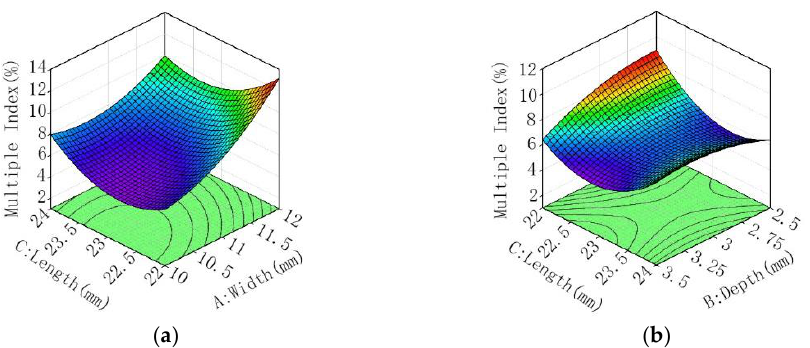
Figure 15. The impacts of interaction factors on the multiple index. ( a ). AC Interaction; ( b ). BC Interaction.